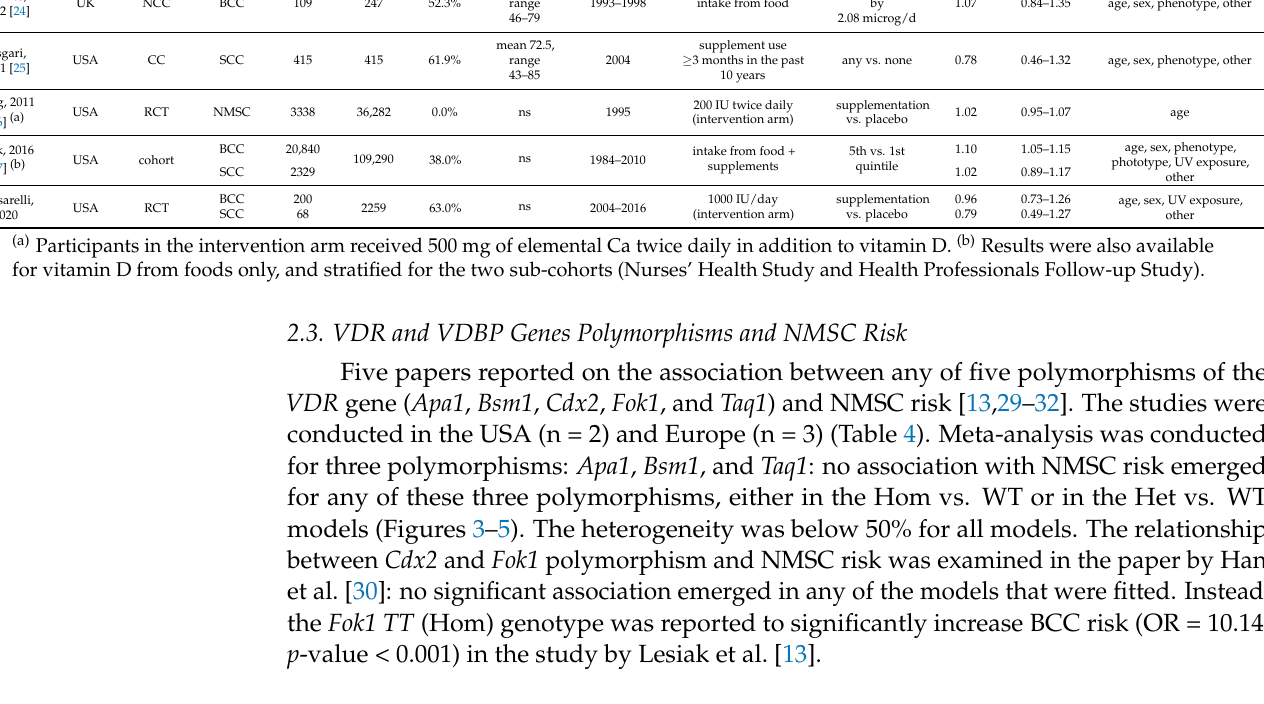
Table 4. Main characteristics of the studies reporting on the association between polymorphisms of the vitamin D receptor ( VDR ) gene and the risk of non-melanoma skin